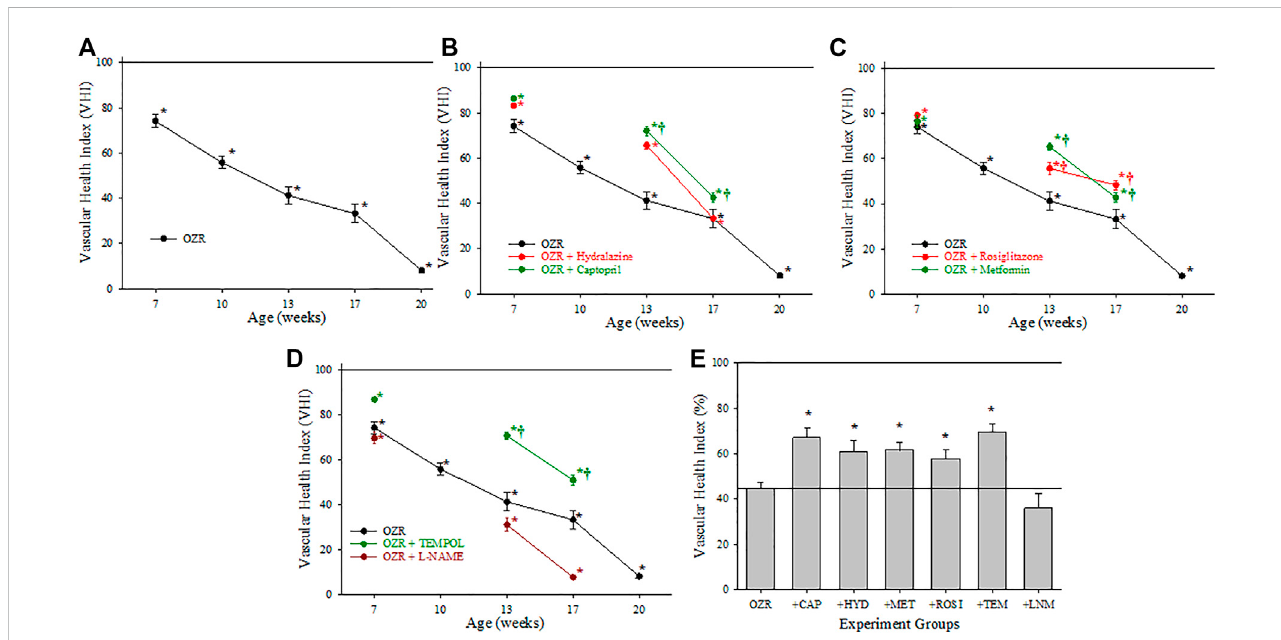
FIGURE 4 Data describing the three-parameter determination of Vascular Health Index (VHI) within the cerebral microcirculation. Data (mean ± SE) are presented for OZR over the age ranges of the present study (A) or the impact of chronic anti-hypertensive (B) , anti-diabetic (C) , or antioxidant/anti-in fl ammatory/nitric oxide bioavailability (D) therapies. (E) presents the aggregate VHI from the different animal groups where all ages have been compiled into one data point. By de fi nition, VHI from LZR is set to 100%. * p < 0.05 vs. LZR at that age; † p < 0.05 vs. OZR at that age. Please see text for details.